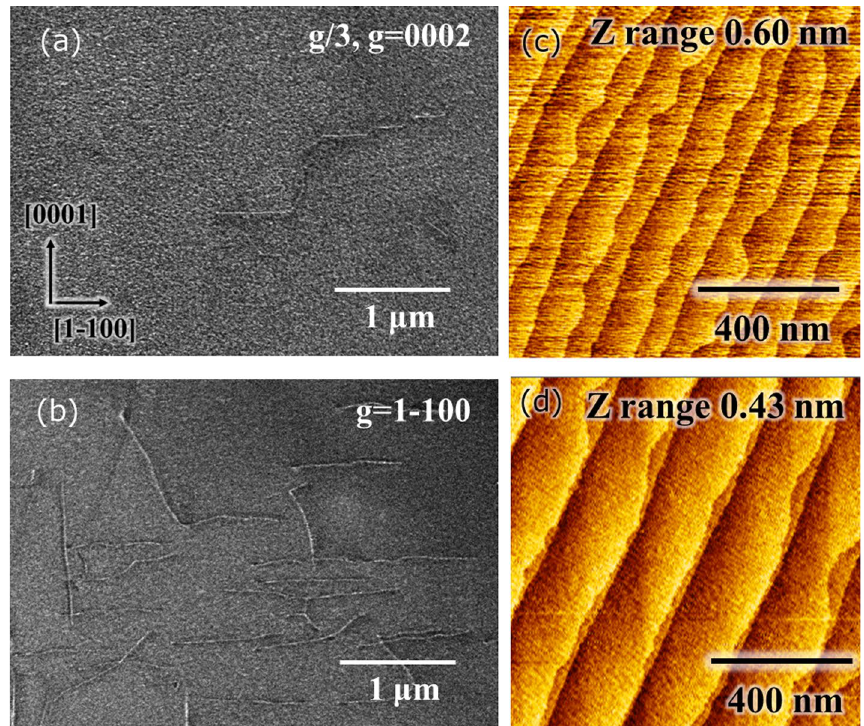
Figure 5. The TEM images focus on the dislocation in grow m-axis and the AFM images. ( a ) The cross- sectional TEM image of a dark field with the g/3, g = [0002] ( b ) The cross-sectional TEM image of a dark field with the g = [1–100] ( c ) AFM image in case of taking-off from the reactor after AlN growth at initial three μm by the high growth rate. The AFM image is a different sample from TEM images; the growth condition is the same as the initial 3 μm. ( d ) AFM image in AlN top surface. This image is the same sample as TEM images. The measurement areas of these AFM images are 1 μm 2